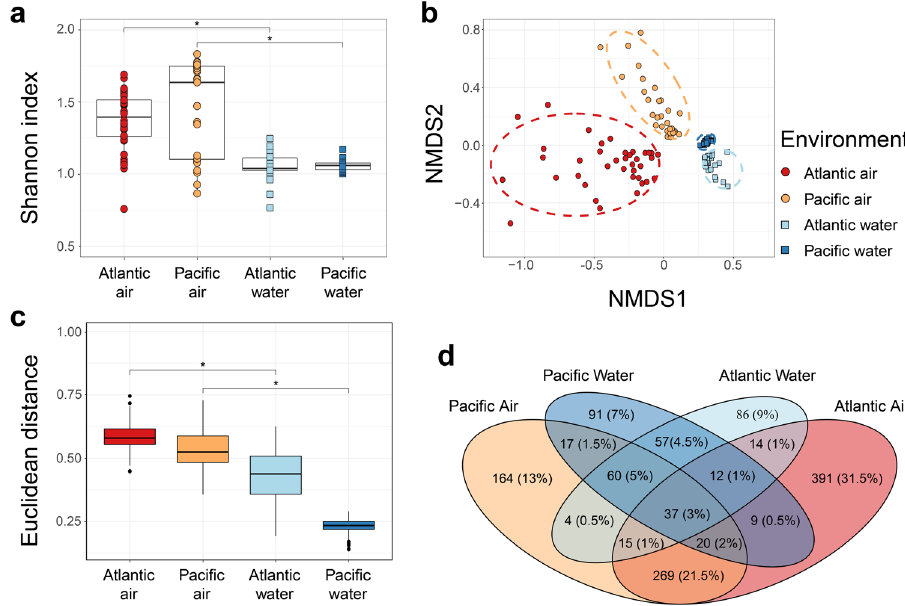
Fig. 2 Similarities and differences in bacterial microbiomes of different oceanic environments. Biome-based diversity (based on the Inverse Simpson index) of amplicon sequence variants (ASVs) detected in more than 5% of the samples ( a ) and clusters represented by nonmetric multidimensional scaling (NMDS) ordination, based on Bray-Curtis dissimilarity metrics ( b ), with 95% con fi dence ellipses. The distance in ASV composition is presented in a heatmap of the Bray-Curtis dissimilarity between all analyzed samples (Bray-Curtis index varies between 0, for an identical ASV composition, and 1, for most distant ASVs between samples) ( c ). A Venn diagram ( VennDiagram 1.6.20) summarizes the number and the percentage (in brackets) out of the total number of bacterial taxa that were observed in the different biomes ( d ). Box plot center lines represent the median values, box limits are the 25 and 75% of the population, upper and lower quartiles represented in bars are 5 and 95% of the population; whiskers represent signi fi cance <0.05, points at ( c ) represent